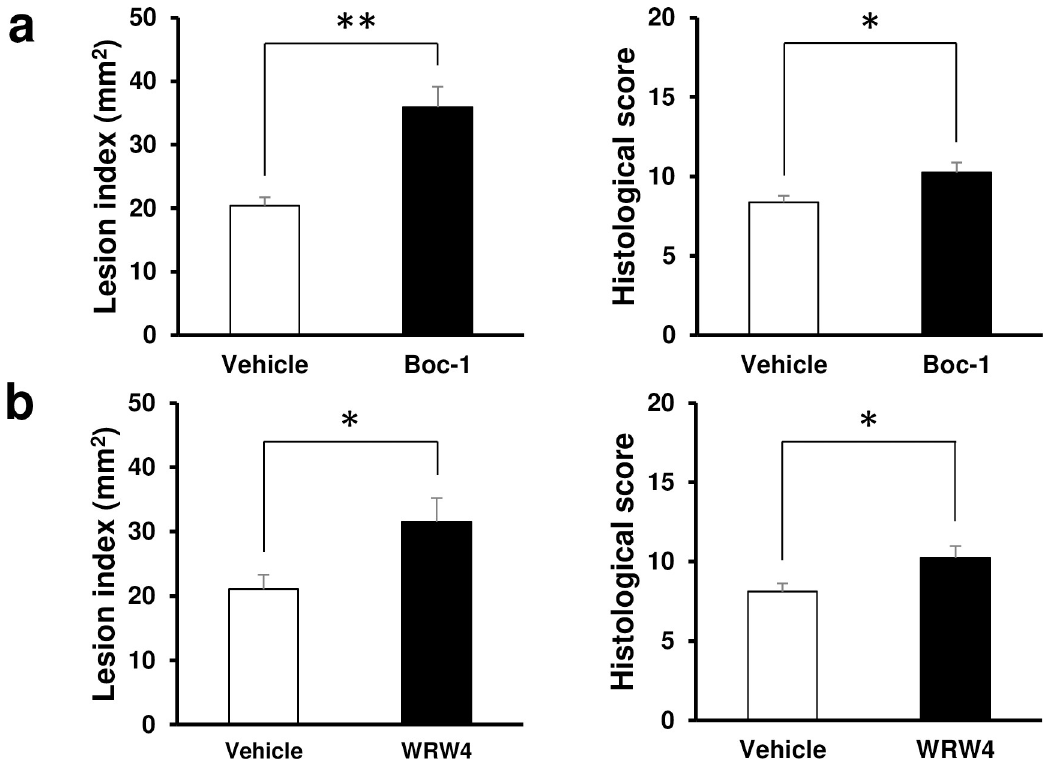
Fig 5. Effect of inhibition of lipoxin A4 receptor /formyl peptide receptor 2 (ALX/FPR2) on indomethacin-induced small intestinal damage. (a) Lesion index and histological score of small intestines 24 h after administration of indomethacin (10 mg/kg BW) in mice pre-administered with vehicle or ALX/FPR2 inhibitor Boc-1 (5 mg/kg BW). N = 8. (b) Lesion index and histological score of small intestines 24 h after administration of indomethacin (10 mg/kg BW) pre-administered with vehicle or ALX/FPR2 inhibitor WRW4 (1 mg/kg BW). N = 6–8. All data are from a single experiment, representative of at least two independent experiments and expressed as mean ± standard error of mean. � p < 0.05, �� p <